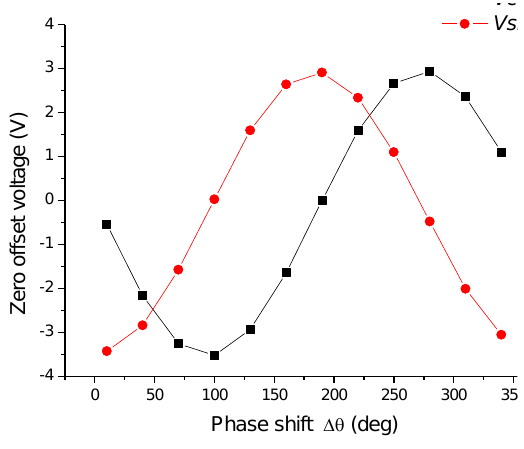
Figure 10. Two orthogonal components of the zero output versus the phase shift 